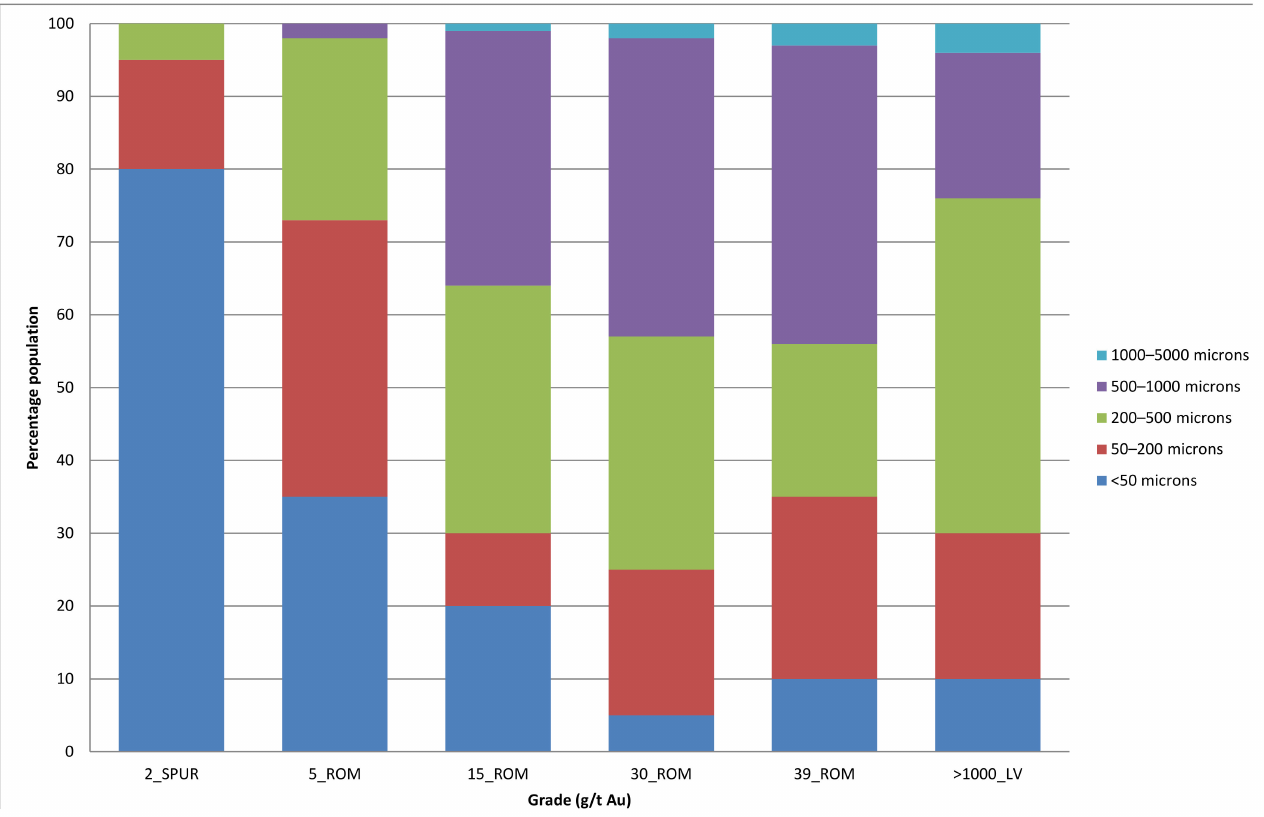
Figure 16. Gold particle size distribution across low (2_SPUR MET5: 2 g/t Au; 5_ROM MET3: 5 g/t Au), moderate (15_ROM MET2: 15 g/t Au), ROM (30_ROM MET4: 30 g/t Au) to high (39_ROM MET1: 39 g/t Au) grades, and ultra-high grade (XCT: >1000_LV g/t